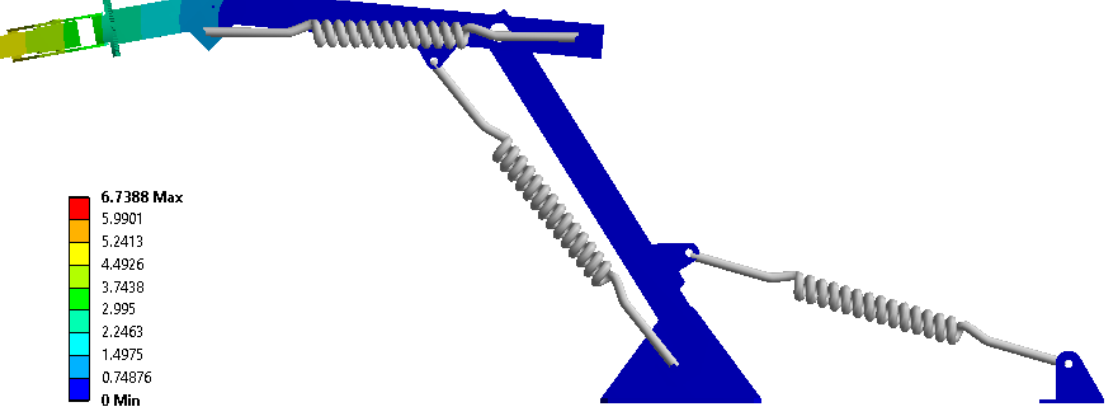
Figure 17. The resulting displacement field for configuration 4 and a force of 15 N.